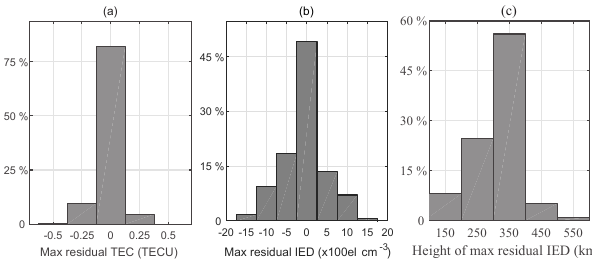
Figure 3. Histogram of maximum residual TEC along the signal path (a) , residual electron density (b) and the heights of the maxi- mum residual electron density (c) .